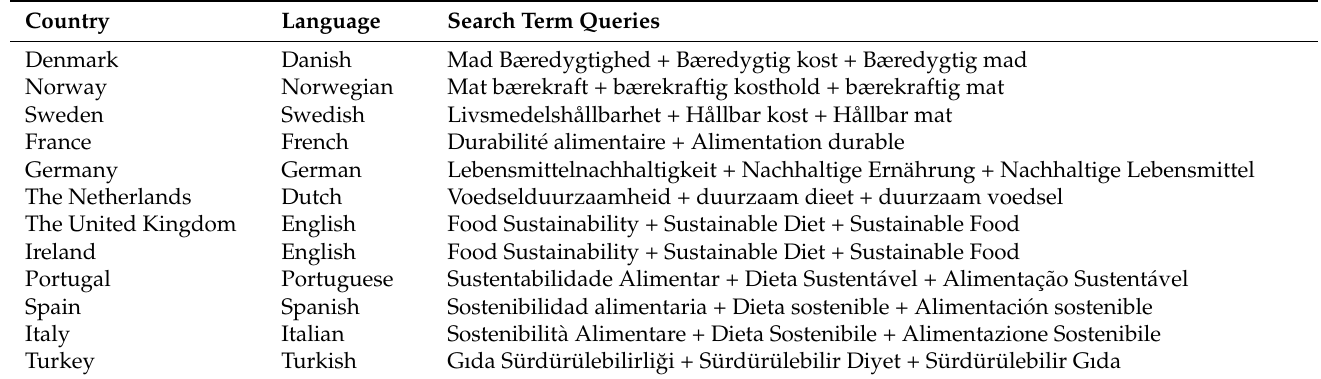
Table 1. The search term combinations for “Food